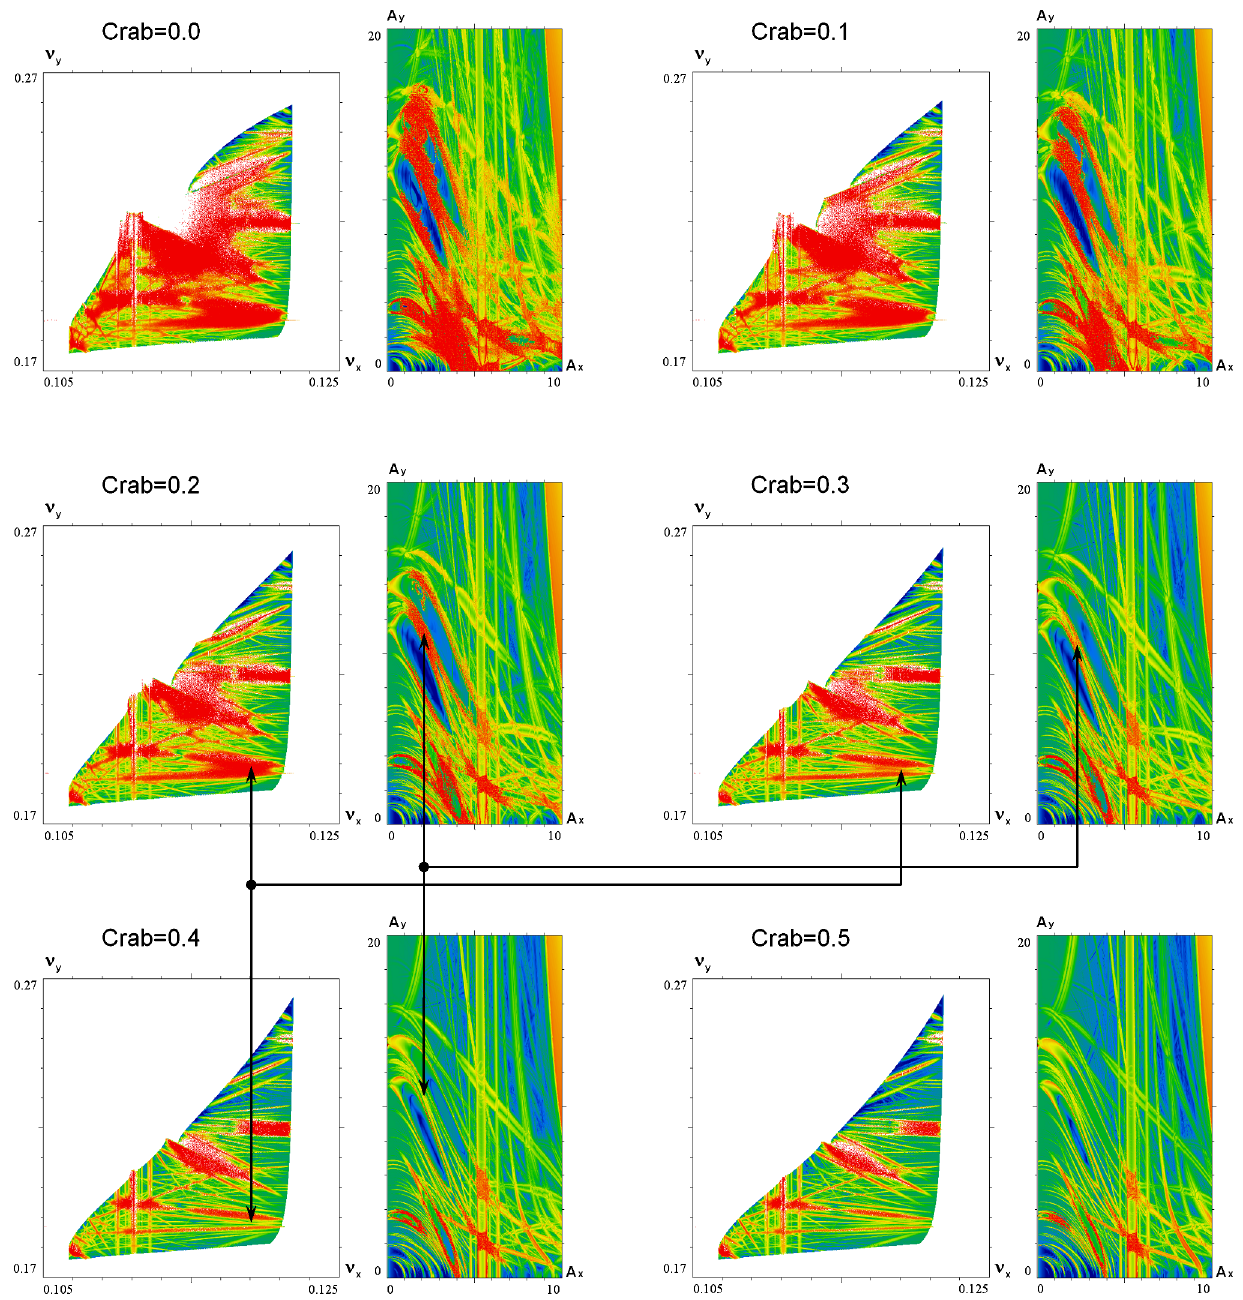
FIG. 7. Beam-beam resonances versus the crab value for DA(cid:1)NE (part